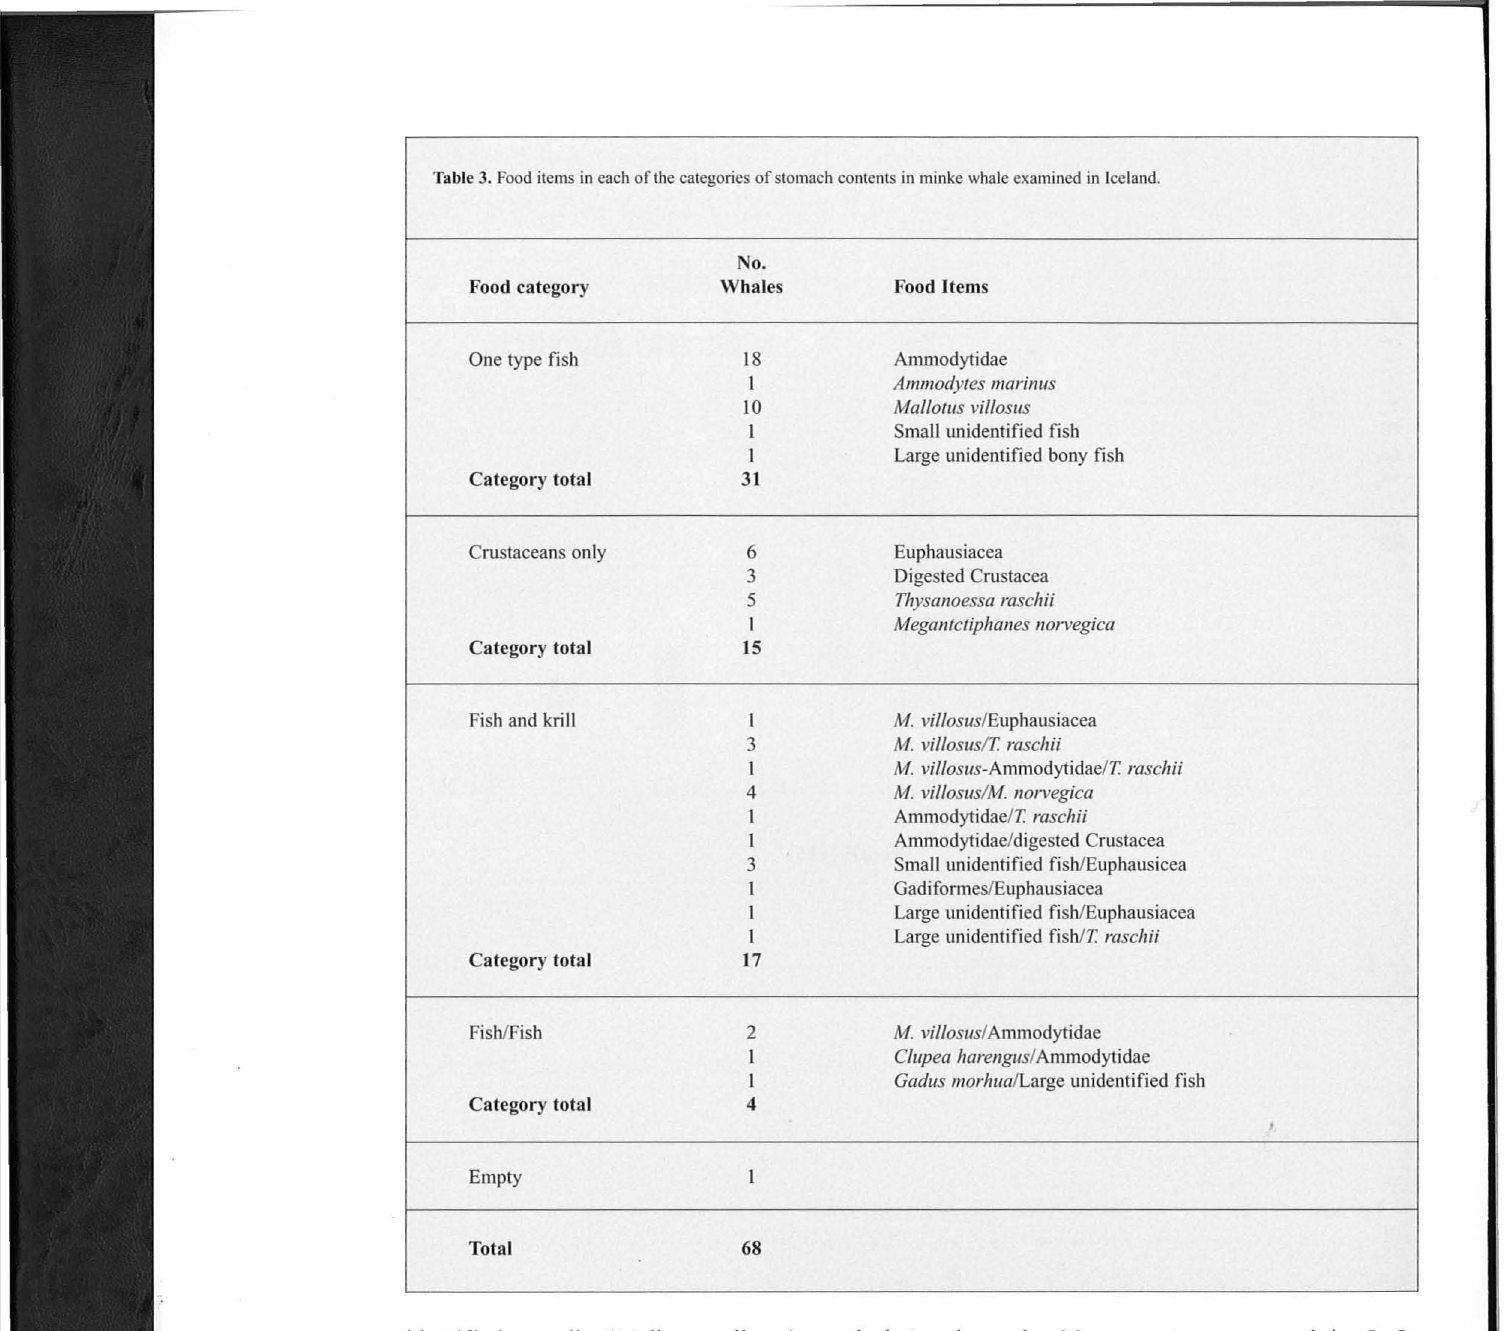
Table 3. Food items in each of the categories of stomach contents in minke whale examined in Iceland.